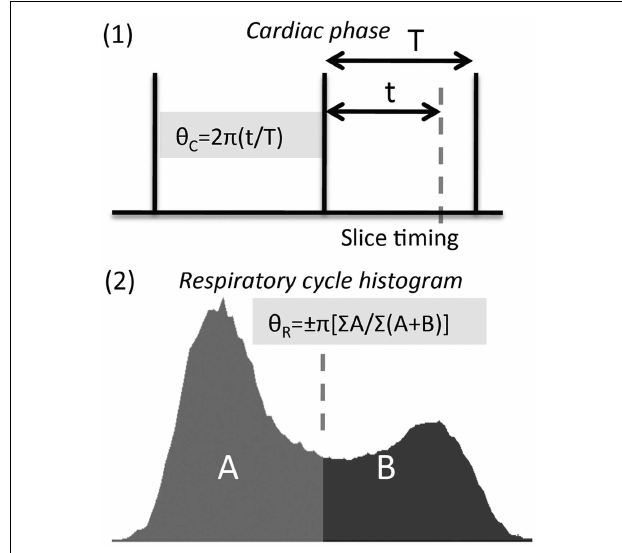
FIGURE 2 | Calculation of cardiac and respiratory phase for RETROICOR . (1) Calculation of cardiac phase begins by identifying consistent features from the cardiac trace, e.g., peak in the pulse-oximeter waveform, R-wave in the electrocardiogram (ECG).The timing of slice acquisition relative to these features (vertical lines above) determines the cardiac phase, varying from 0 to 2 π . (2) Respiratory phase needs to be calculated differently (see Glover et al., 2000), as both the timing and depth of breathing need to be accounted for, and inspiratory phase distinguished from expiratory phase using a sign change (i.e., phase range is − π to + π